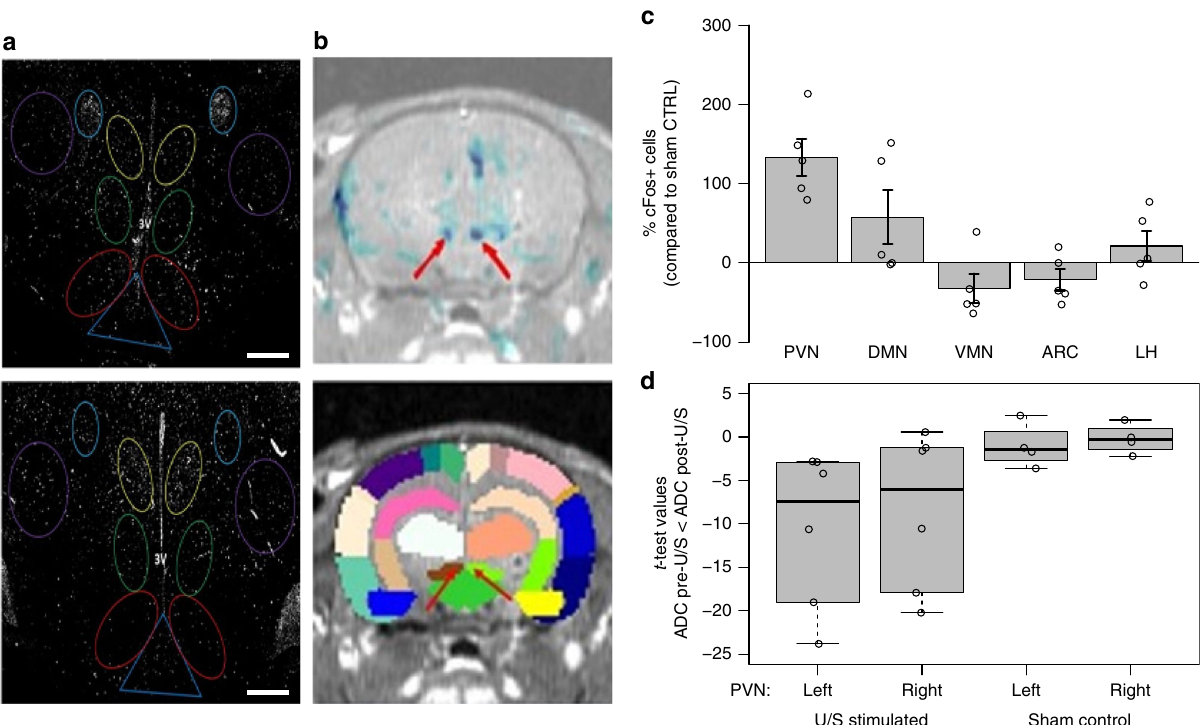
Fig. 7 Histochemical and DfMRI analysis of neural pathways associated with response to hepatic U/S stimulation. a cFOS immunohistochemistry images showing the number of activated neurons in the (top) unstimulated control and (bottom) U/S-stimulated animals. Images were segmented on the paraventricular nucleus (yellow; PVN), dorsal medial nucleus (green; DMN), ventromedial nucleus (red; VMN), arcuate nucleus (dark blue; ARC), and lateral hypothalamus (purple; LH). Scale bar = 300 microns. b Example MRI overlays between activation maps and the T1 SPGR volume (top; see Methods for details) and a brain atlas overlay on the T1 SPGR volume (bottom; see Methods, Supplementary Figures 13 and 14, and Supplementary Table 2 for further details). The blue color in the top image denotes regions where ADC changed signi fi cantly post-U/S. Each color in the bottom image represent anatomically distinct brain regions in the atlas; major areas showing decreased ADC (top image; red arrows) aligned with the left (brown) and right (light green) PVN in the bottom image (red arrows). c Data showing the percent change of the number of cFos expressing cells in the US stimulated animals ( n = 8) compared to sham controls ( n = 6) in each of the segmented hypothalamic regions (PVN, DMN, VMN, ARC, and LH), images in ( a ) represent one set of sham versus stimulated paired animals. d T -test values from corresponding-pixel comparison within PVN ROIs (see Methods for details) between the pre- and post-treatment ADC maps showing increased ADC values (compared to controls) for the 6 animals tested after U/S stimulation, images from ( b ) represent results from one exemplar animal. All experiments in this fi gure were performed using the same U/S parameters as Figs. 3 – 6, except the DfMRI experiment in which a MR compatible ultrasound transducer was needed. The compatible ultrasound transducer had an acoustic frequency of 1.47 MHz. The band inside the box shows the second quartile, while the whiskers represent the minimum and maximum of all the